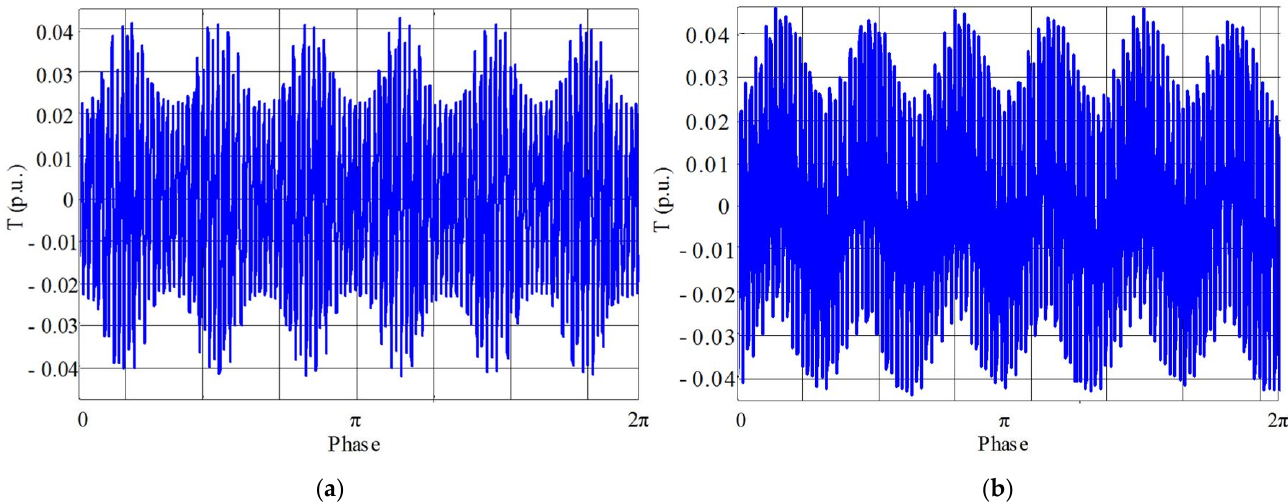
Figure 10. Simulated torque of pulse-width modulated voltage-source inverter (PWM-VSI)-fed induction machine: ( a ) unsaturated; ( b ) at the “knee” of the magnetization characteristic [6].